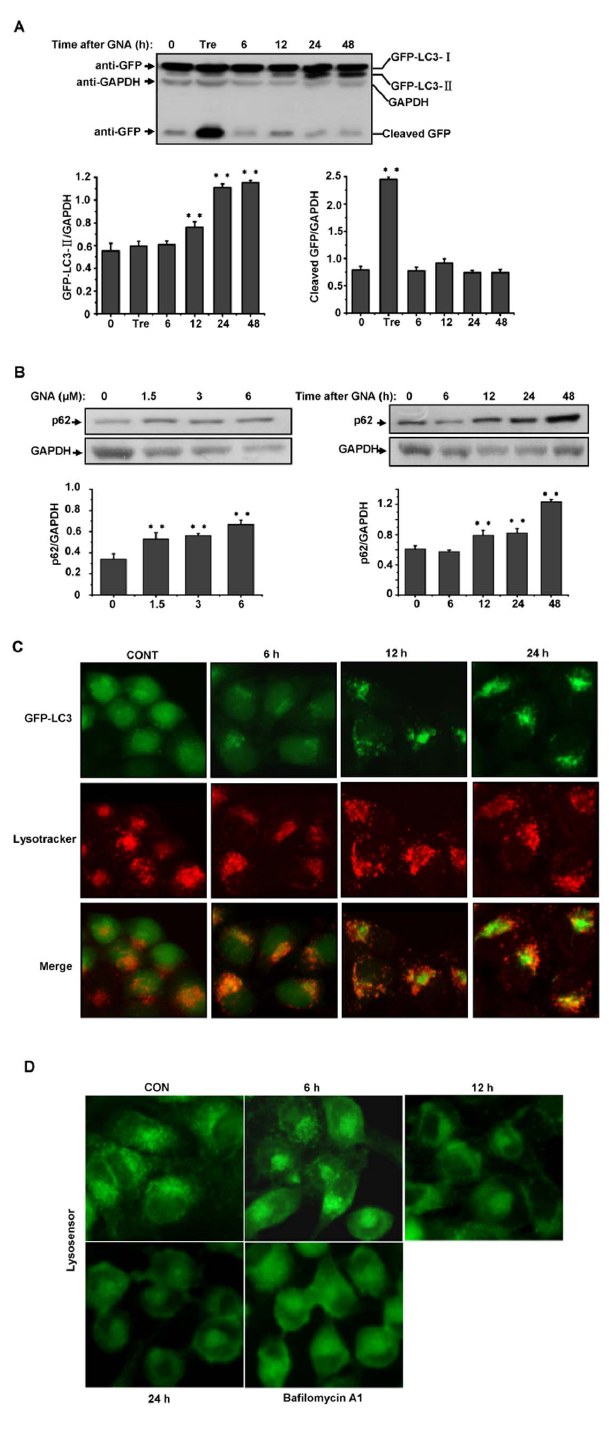
Figure 4. GNA inhibits the fusion between autophagosomes and autolysosomes. A, Effect of GNA on the flux of autophagy. GFP- LC3/HeLa cells were cultured in the absence (control) or presence of 3 m M of GNA for the indicated periods of time, and the level of cleaved GFP was analyzed by western blotting using an anti-GFP antibody; 100 mM trehalose was used as a positive control. GAPDH protein was used as the loading control. The bar graph shows the band intensities of GFP-LC3-II or cleaved GFP relative to those of GAPDH. Mean 6 SEM, n=3, *means p , 0.05, ** p , 0.01, one-way ANOVA. B, Dose- and time- dependent effects of GNA on p62 degradation. A549 cells were treated with various concentrations of GNA for 24 hours or 3 m M GNA for